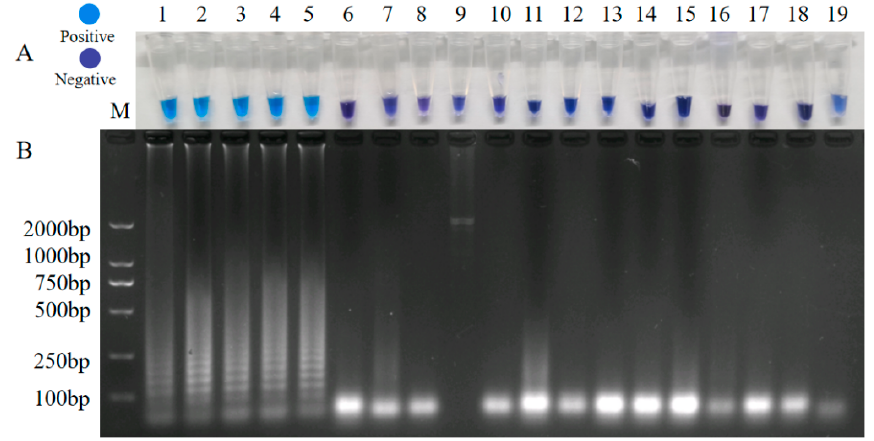
Figure 8. The specificity test of the LAMP assay of A. phaeospermum. ( A ) Color rendering change plot; ( B ) agarose gel electrophoresis. M: DL 2000 DNA marker; 1–18: strain number is the same as in Table 1; 19: negative control.